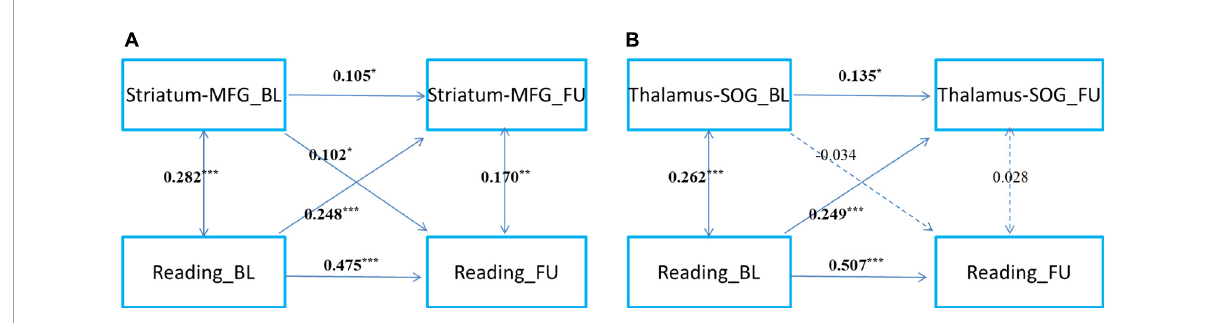
FIGURE2 The cross-time predictions between cortical-subcortical functional connectivity and reading development in school-age children The cross-lagged panel models of (A) left striatum and left middle frontal gyrus connectivity, (B) right thalamus and superior occipital gyrus and reading development. MFG, middle frontal gyrus; SOG, superior occipital gyrus. Standardized estimates are presented. Age, sex, handedness, site, household income, parental education, and head motion were used as covariates of no interest. * p < 0.05, ** p < 0.01, *** p <